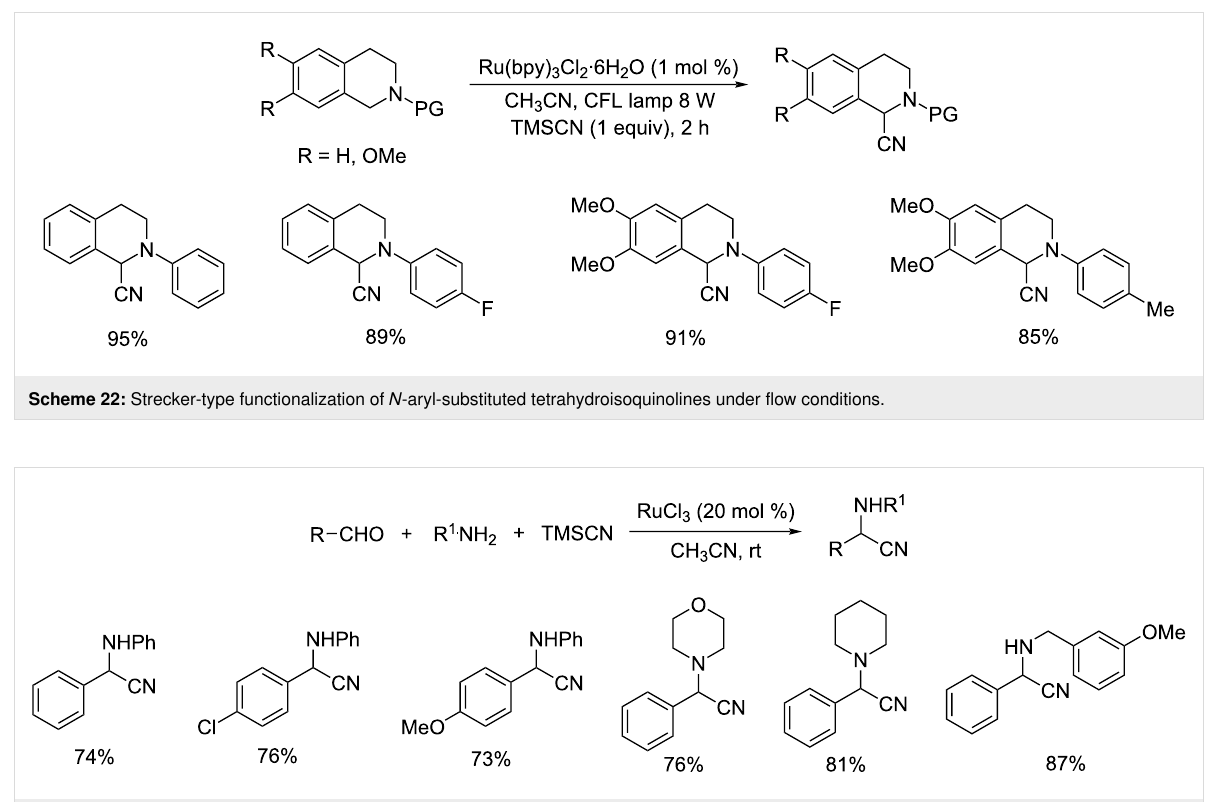
Scheme 23: One-pot synthesis of α -aminonitriles using RuCl 3 as